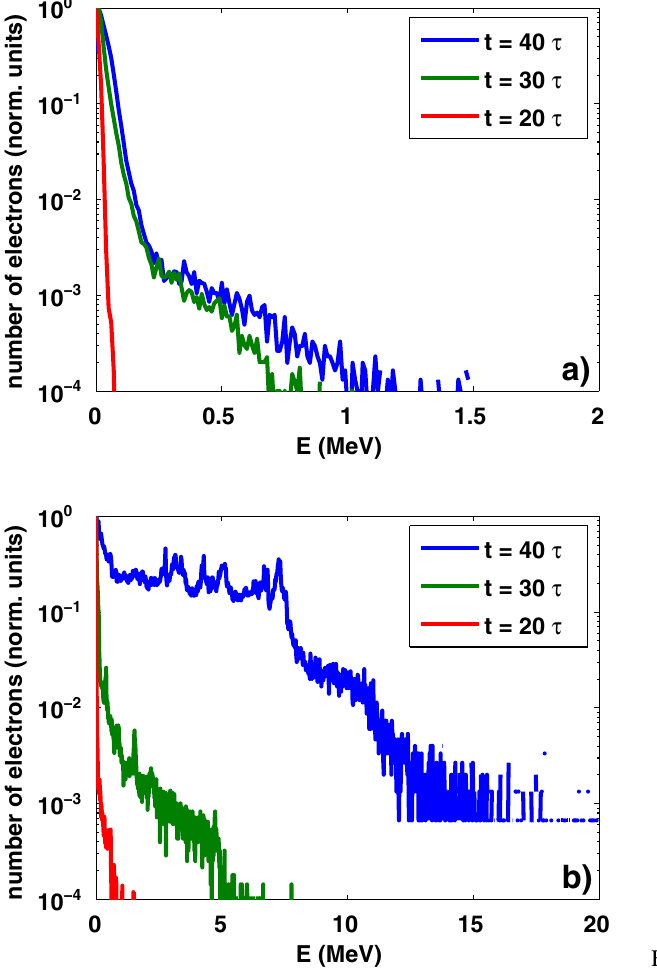
FIG. 1. (Color) Temporal evolution of the electron energy dis- tributions in the 1D3V PIC simulation during the interaction of circularly (a) and linearly (b) polarized relativistic ( I 10 20 W = cm 2 ) laser pulse with ultrathin (32 nm) overdense ( n 2 : 1 (cid:2) 10 23 cm (cid:4) 3 ) foil. The distributions contain all simulation electrons and they are normalized to have the same maximum values. The laser pulse is 100 fs long ( sin 2 temporal envelope) and the time is measured in laser periods (cid:2) . At the time 40 (cid:2) (maximum intensity on the target), the foil irradiated by the linearly polarized laser pulse becomes transparent to the laser pulse. Note the different scales on